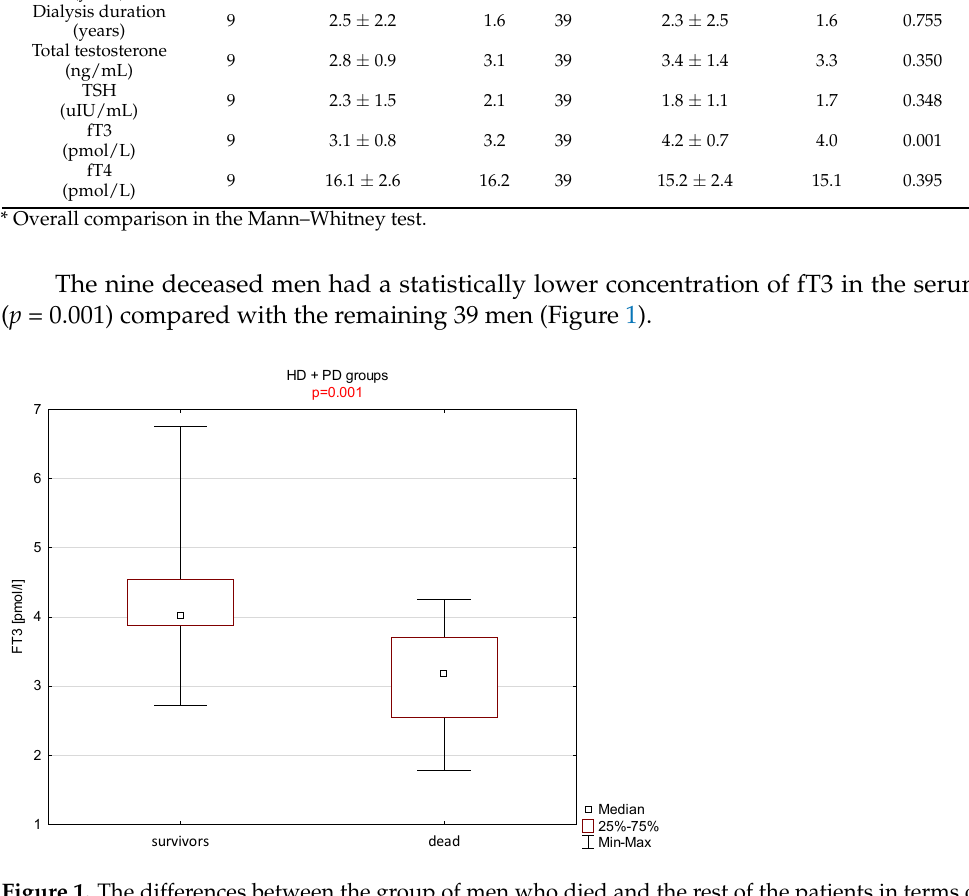
Table 4. ROC analysis of the selected hormone serum concentrations in the determination of prog- nosis in male dialysis patients.